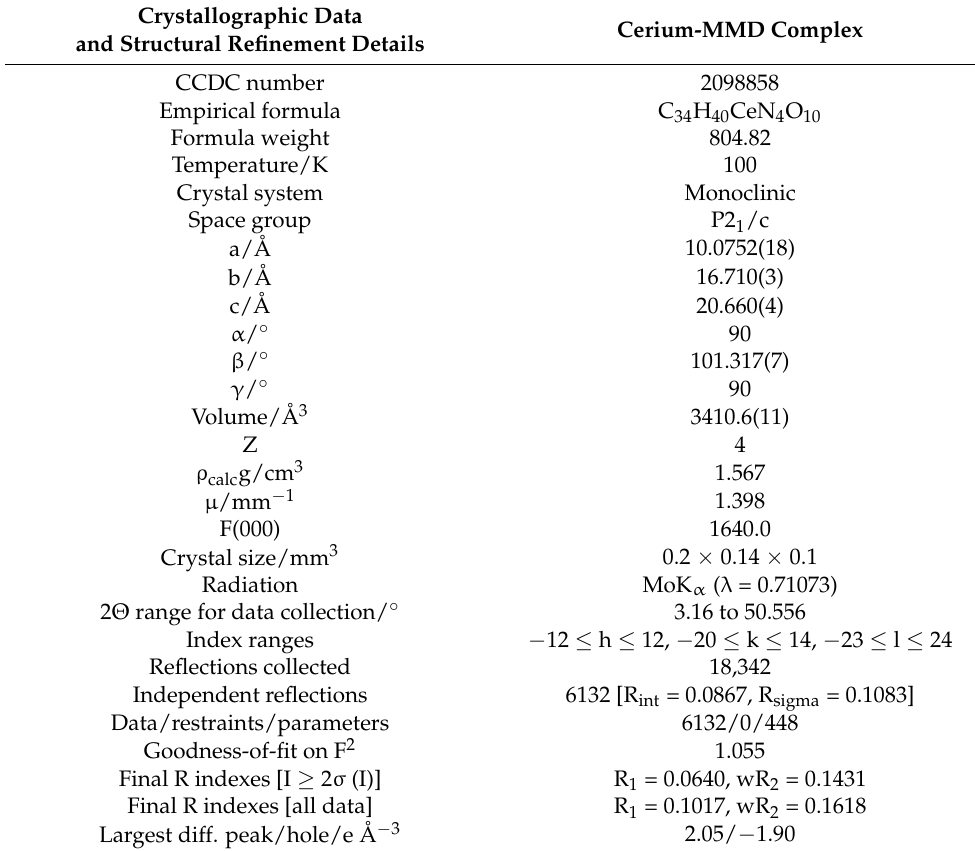
Table 1. Crystal data and structure refinement details for the cerium-MMD